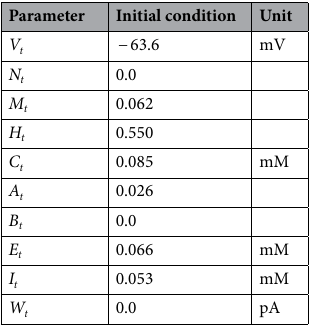
Table 1. Initial conditions and values used in the